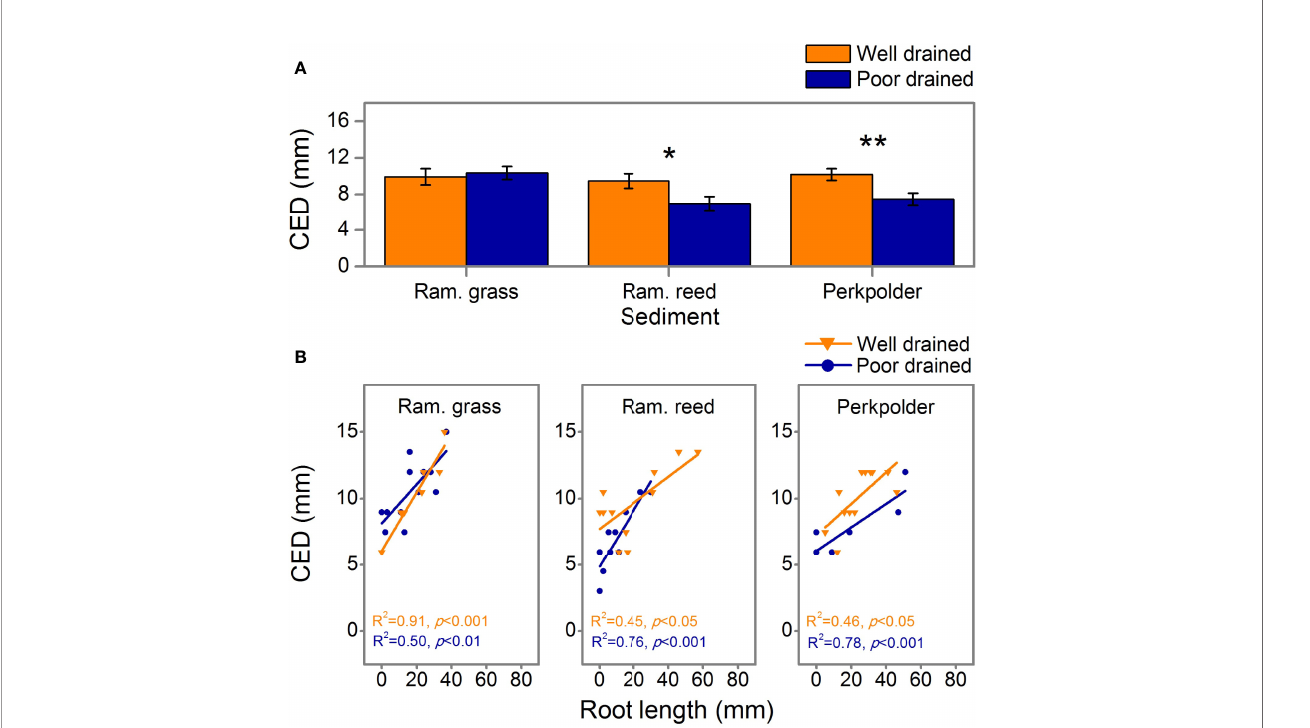
FIGURE 3 | (A) Critical erosion depth (CED) of survived seedling in the mesocosm experiment (data is presented as mean + se. Signi fi cance level: *0.05, **0.01). (B) The relationship between CED and seedling root length, R 2 and p values are presented at the bottom of each column. Note that data points are not equally plot due to different seedling survival. Colors indicate the same as Figure 2B